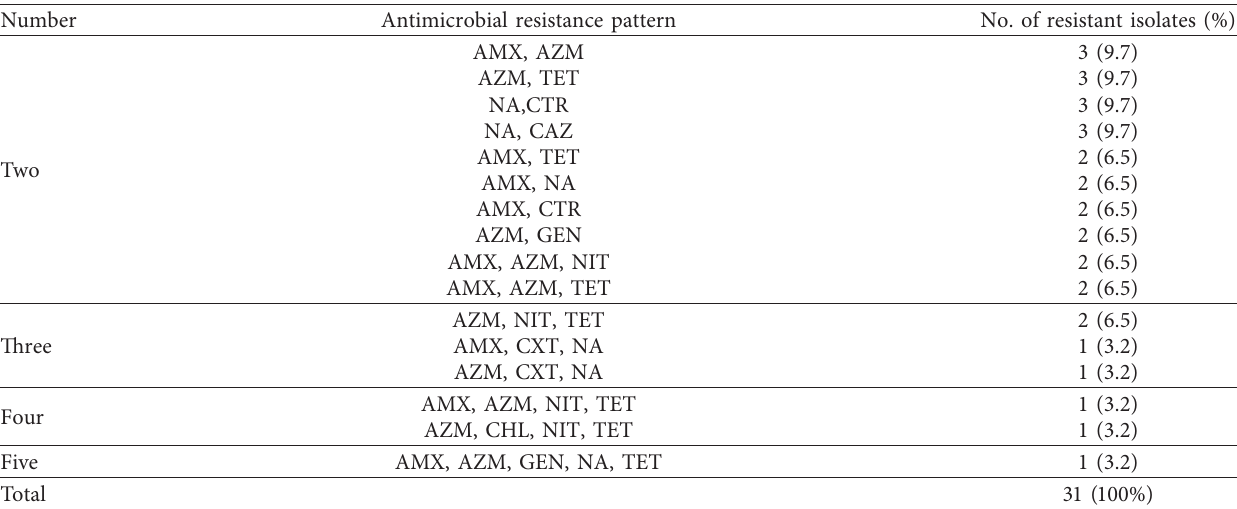
Table 4: Multidrug resistance patterns in Salmonella isolated from meat samples in Ambo and Holeta